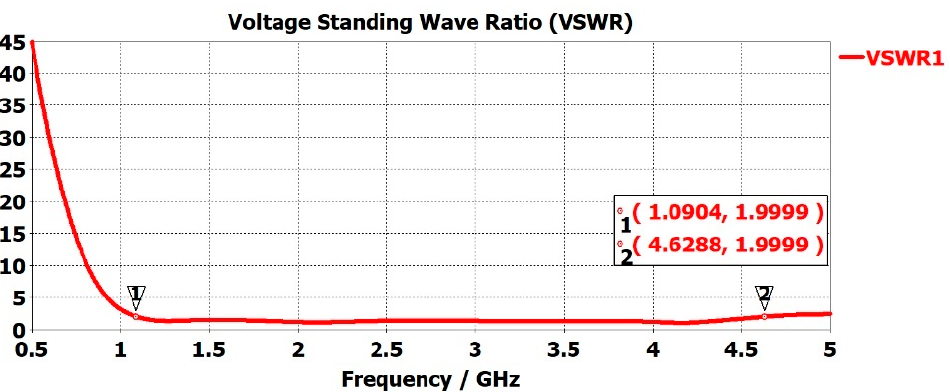
Figure 6. Sensor VSWR versus frequency response.